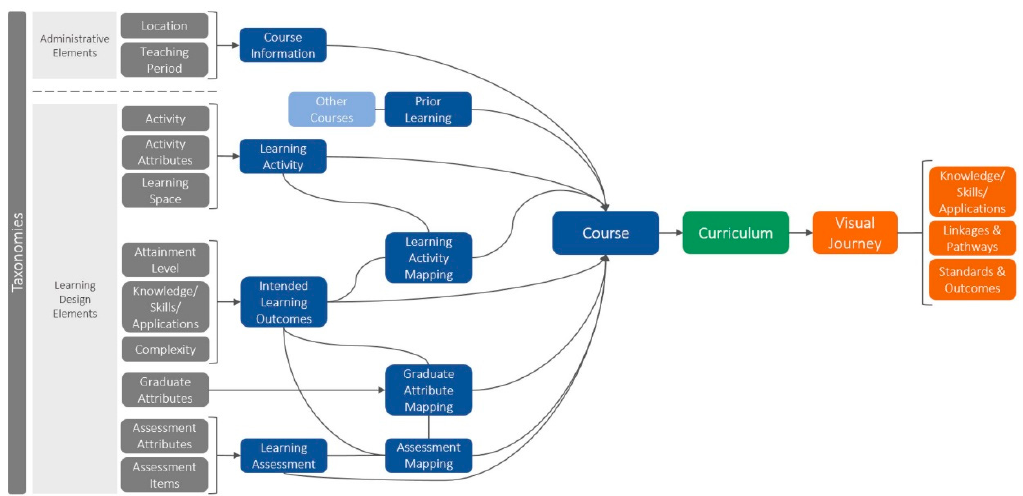
Figure 8. Overview of The Journey Maker design-environment functionality.